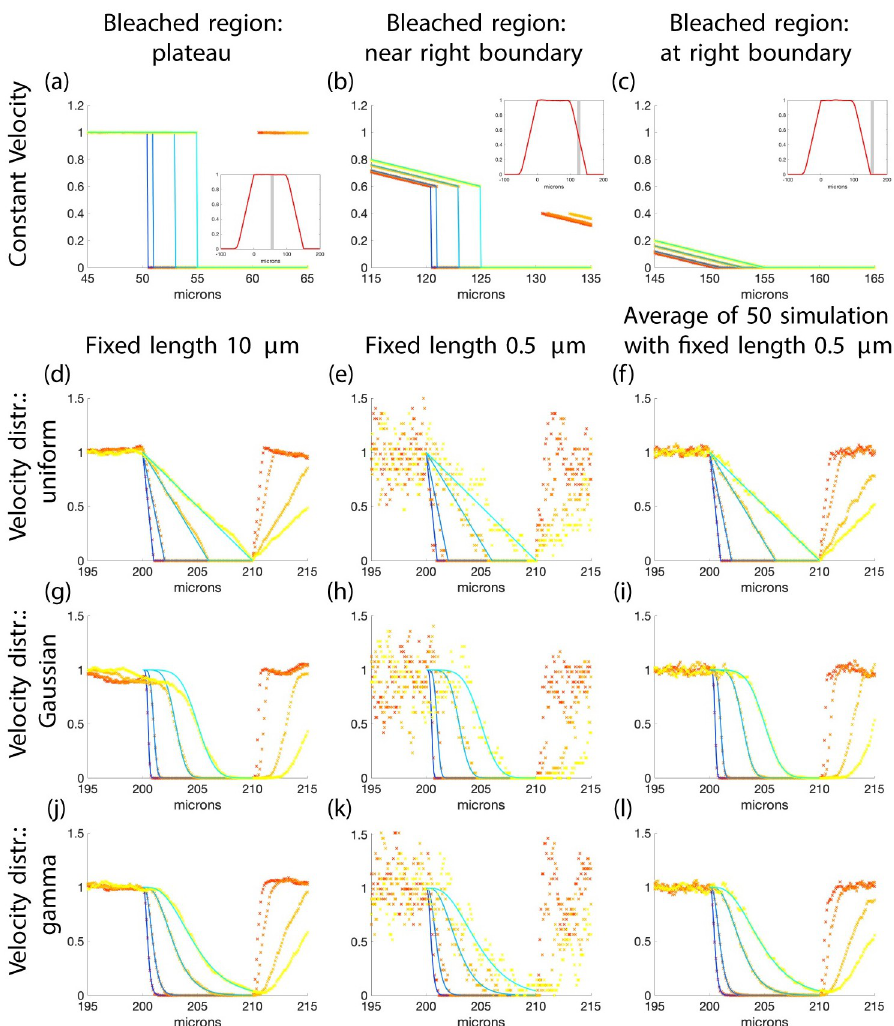
Fig 4. Impact of velocity distributions and filament length on FRAP intensity profile curves from the theory and type 1 simulations. The solid curves in (a)-(c) are plots of a scaled version of Eq (4) and in (d)-(l) they are a scaled version of Eq (5) such that k f k 1 = 1. The x’s are simulated results. The mean velocity for all simulations is 1 micron per minute and for (g)-(l) the standard deviation of the velocity is 0.25. In (a)-(c) the velocity is fixed and the insets show the simulated profile curves for the entire domain before bleaching and the region to be bleached is shown in grey. The bleached region is 50–60, 120–130, and 150–160 respectively. In (d)-(f) the velocity is uniformly distributed, (g)-(i) have Gaussian distributions, and (j)-(l) have gamma distributions. Panels (d), (g), and (j) have filaments with length 10 microns; (e), (h), and (k) have filaments with length 0.5 microns; and (f), (i) and (l) shows the average of 50 simulations (each a different realization) with filament length 0.5 microns. In these simulations, each filament has a velocity which does not change for the duration of the simulation. Each simulation in (a)-(c) has 200,000 filaments and in (d)-(l) 20,000. The right endpoints are uniformly distributed in (a)-(c) from 0 to 100 and in (d)-(l) from 0 to 470. The bleached region in (d)-(l) is from 200 to 210. The curves and x’s represent times 0.5 (blue and red), 1 (light blue and orange), 3 (lighter blue and light orange), and 5 minutes (cyan and yellow). The y axis is fluorescence intensity (a.u.) in all panels. Length : Row one—Gaussian, μ = 50, σ = 5 microns. Rows 2,3, and